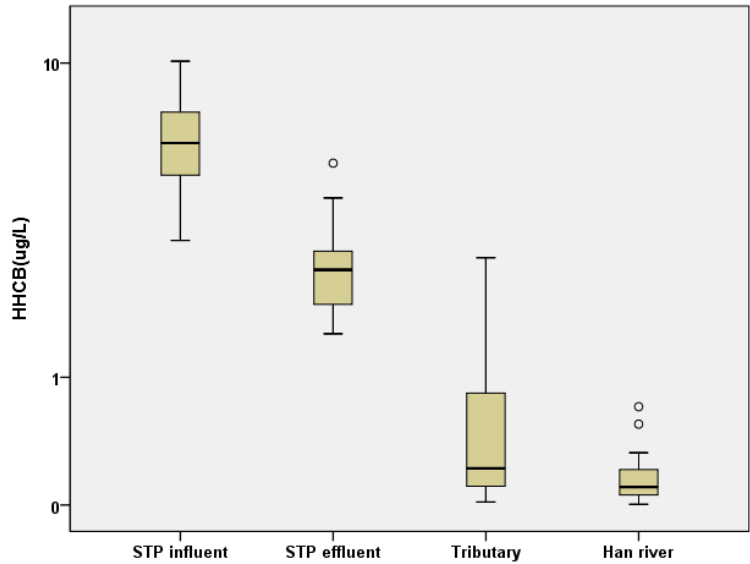
Figure 3. The concentration distribution of HHCB in the samples of STP influent, effluent, tributary, and mainstream of the Han River.